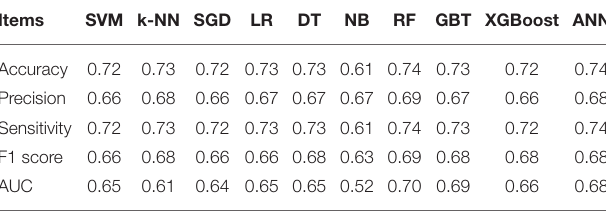
TABLE 1 | Model evaluation indices of the 10 machine learning prediction of the four selected emotions.